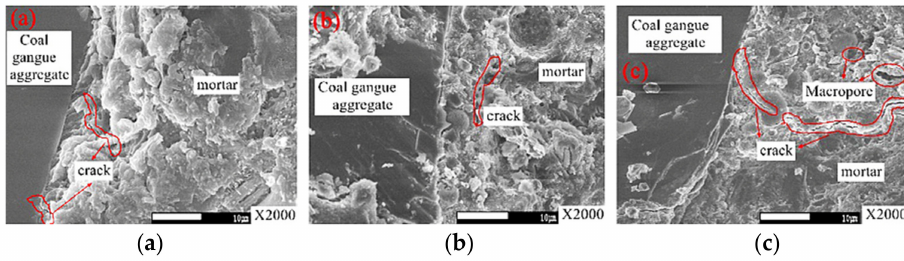
Figure 18. Cracks and pores in interfacial transition zone [96]: ( a ) Common coal gangue concrete, ( b ) 30% fly ash, ( c ) 40% fly ash.